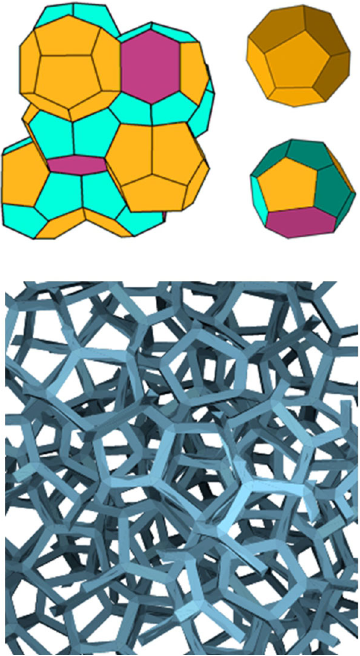
FIG. 3. The Wearie-Phelan honeycomb cell (top left), its constituent polyhedra (top right), and a numerically simulated reticulated foam thereof